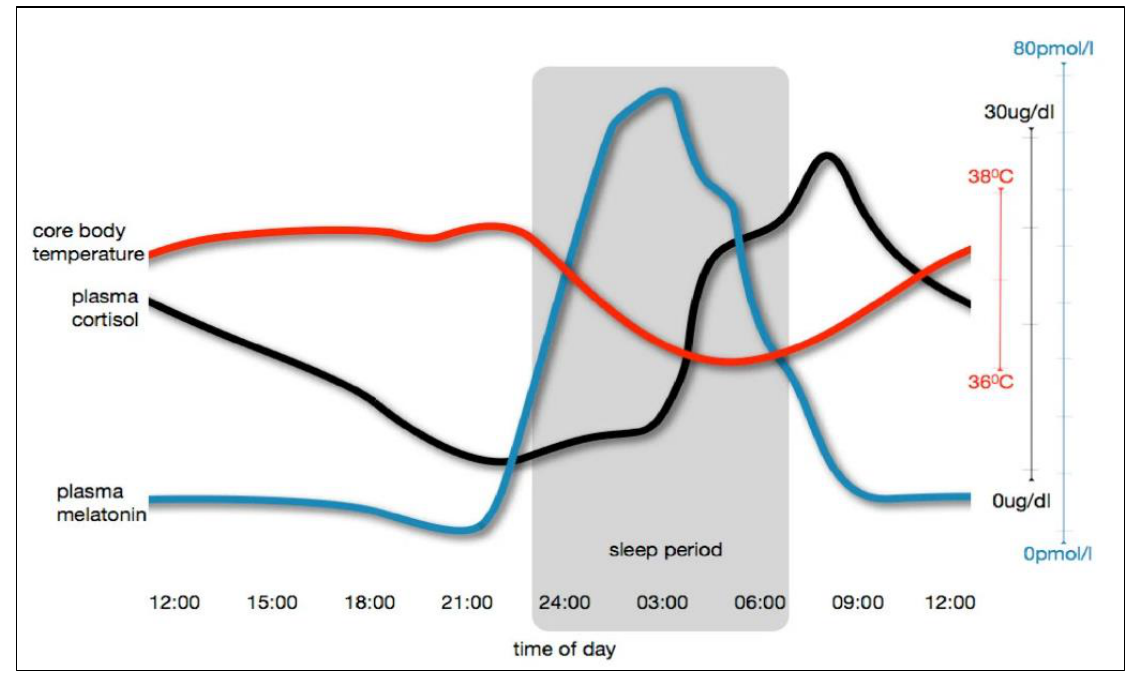
Figure 2. Within-day variations observed in the body temperature and melatonin and cortisol concentrations; reprinted from Ref. [84]. The within-day variation in body temperature is in the opposite direction to the variation observed in melatonin and cortisol.